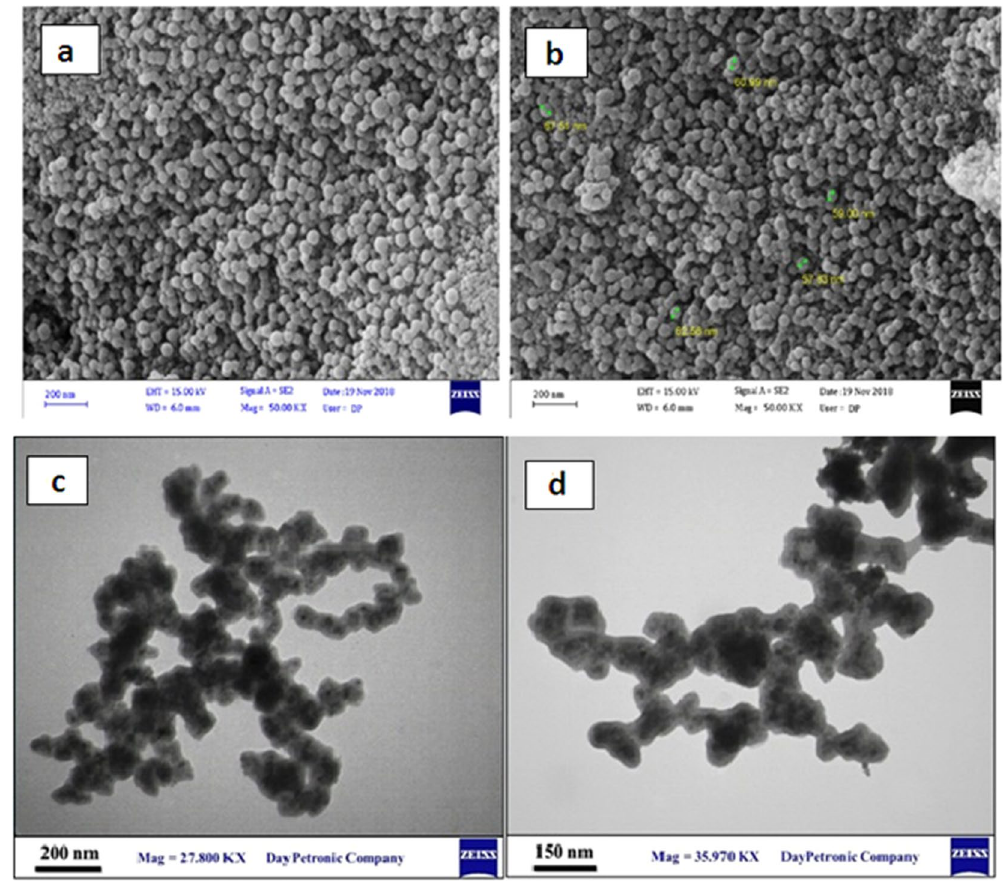
Figure 2. ( a,b ) SEM image of PS@Fe 3 O 4 , ( c,d ) TEM image of PS@Fe 3 O 4